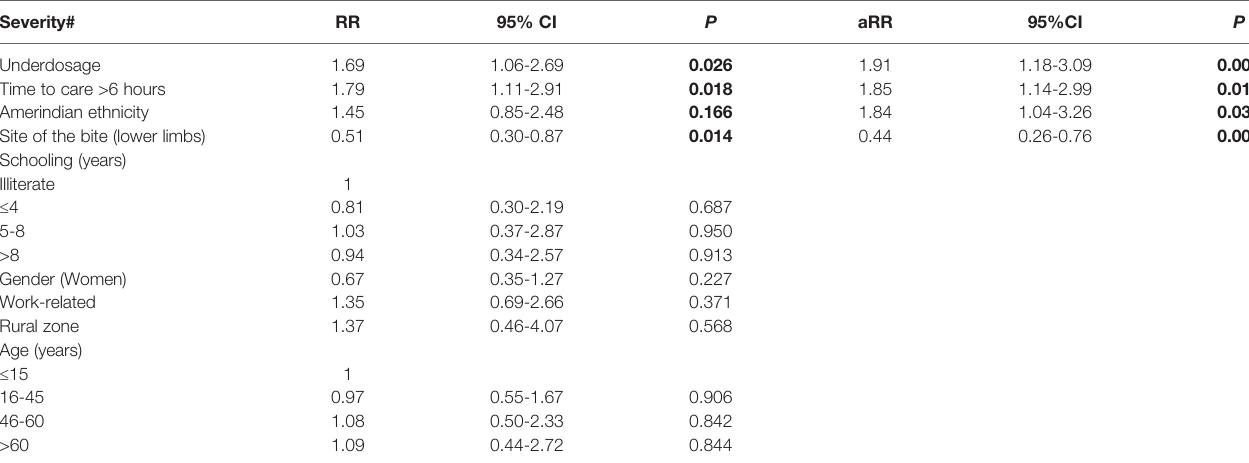
TABLE 4 | Severity classi fi cation of Crotalus bites according the Brazilian Ministry of Health. Signs/symptoms Case severity Mild Moderate Severe Neuroparalytic manifestations (myasthenic facies and others) Mild Evident Evident Myalgia Absent Mild Evident Dark urine Absent Mild Evident Oliguria/anuria Absent Absent Evident Source: Brazilian Ministry of Health (139).